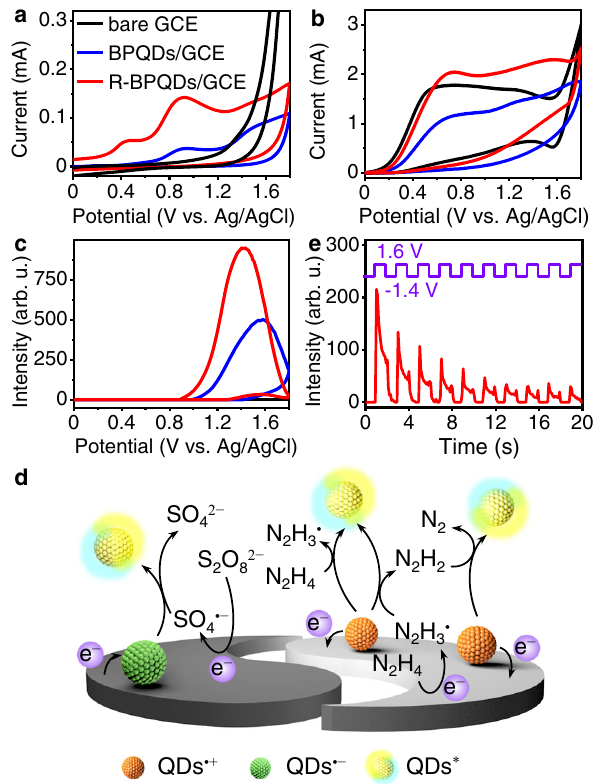
Fig. 3 | Anodic ECL and transient ECL before (BPQDs/GCE, blue) and after Arg modi fi cation(R-BPQDs/GCE,red).a , b CVsand c anodicECLcurveswithbareGCE as reference (black) in 0.1MpH 7.4 PBS in the absence ( a ) and ( b , c ) presence of 25mMN 2 H 4 ∙ H 2 O.PMT=600V. d ProposedmechanismofcathodicandanodicECL for Arg-modi fi ed BPQDs/GCE in the presence of K 2 S 2 O 8 or N 2 H 4 ∙ H 2 O, respectively. e Transient ECL of R-BPQDs/GCE in 0.1M PBS by stepping potential (purple) from − 1.4V to +1.6V at 1Hz. Source data are provided as a Source Data fi